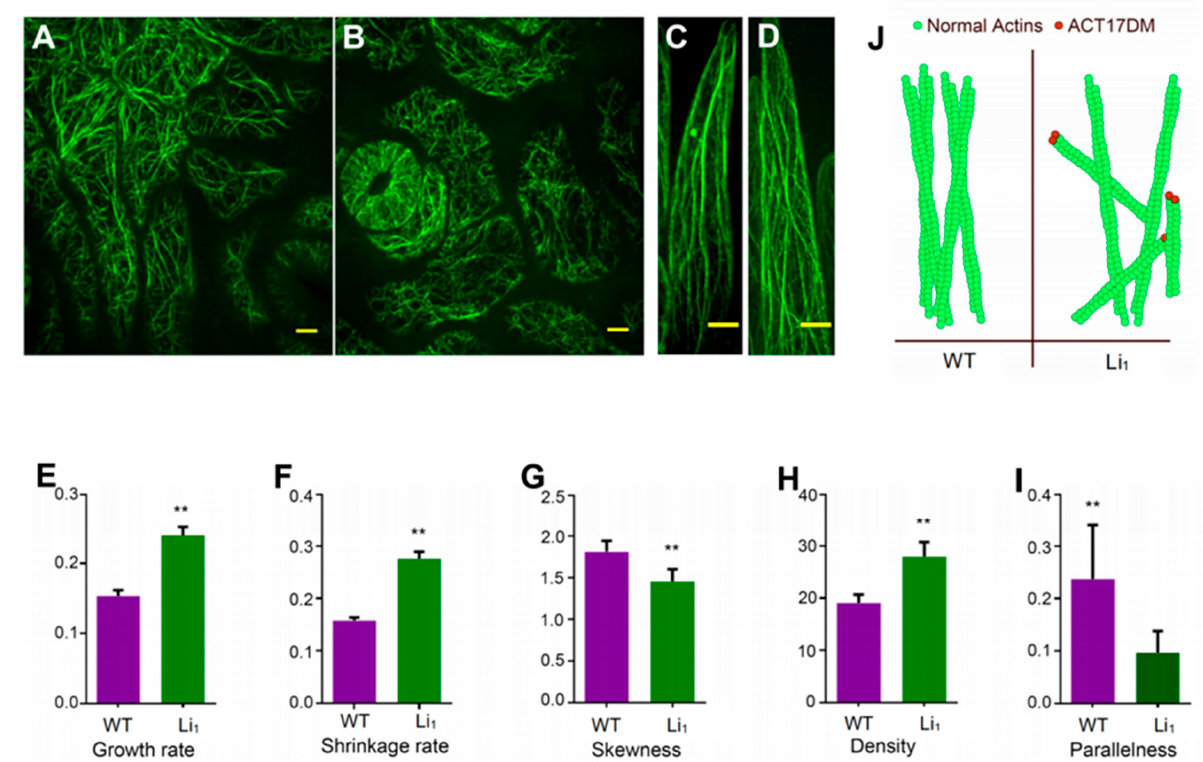
Figure 4. The architectures and dynamic behaviors of F-actin in the Li 1 mutant and the wild-type . ( A ), F-actin architectures in epidermal pavement cells of the wild-type. ( B ), F-actin architectures in epidermal pavement cells of the Li 1 mutant. ( C ), F-actin architectures in fiber cells of the wild-type. ( D ), F-actin architectures in fiber cells of the Li 1 mutant. ( E – I ), Comparison of the parameters (growth rate, shrinkage rate, skewness, density, and parallelness) of F-actin dynamics in fiber cells between the Li 1 mutant and the wild-type. ( J ), Proposed model II for interpreting the effects of GhACT17DM in F-actin elongation. Black arrows represent the elongation direction. Scale bars, 10 µ m. The two asterisks represent highly significant difference.